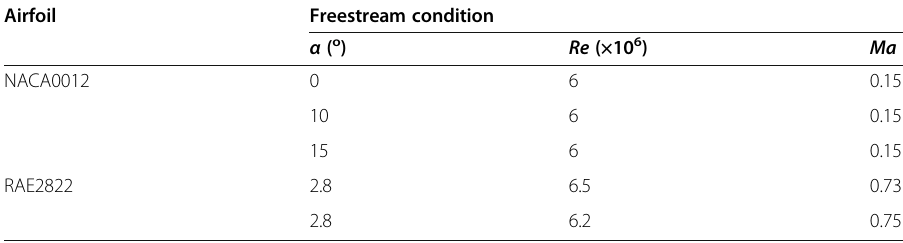
Table 3 The freestream condition of the benchmark cases Airfoil